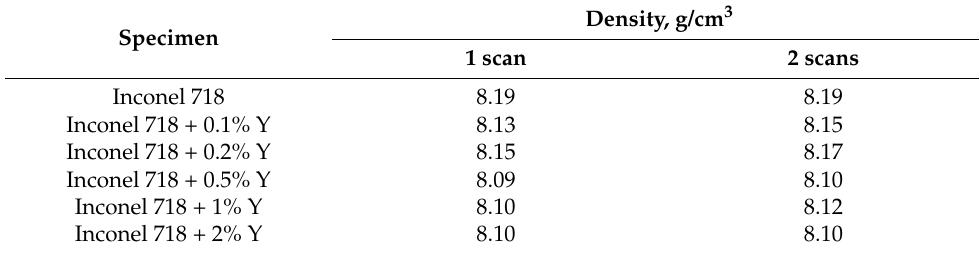
Table 1. Results of the density measurements of the samples.